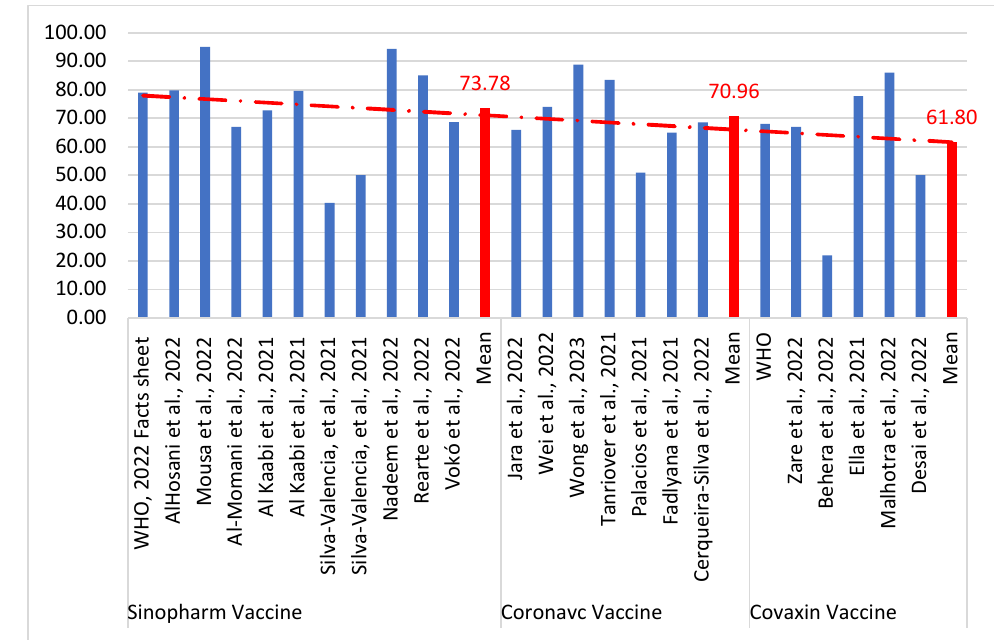
Figure 3. Efficacy of the Sinopharm, CoronaVac, and Covaxin vaccines for the prevention of COVID-19 [29–50]. Table 3. Efficacy of Sinopharm, CoronaVac, and Covaxin COVID-19 vaccines in the prevention of COVID-19 cases and hospital